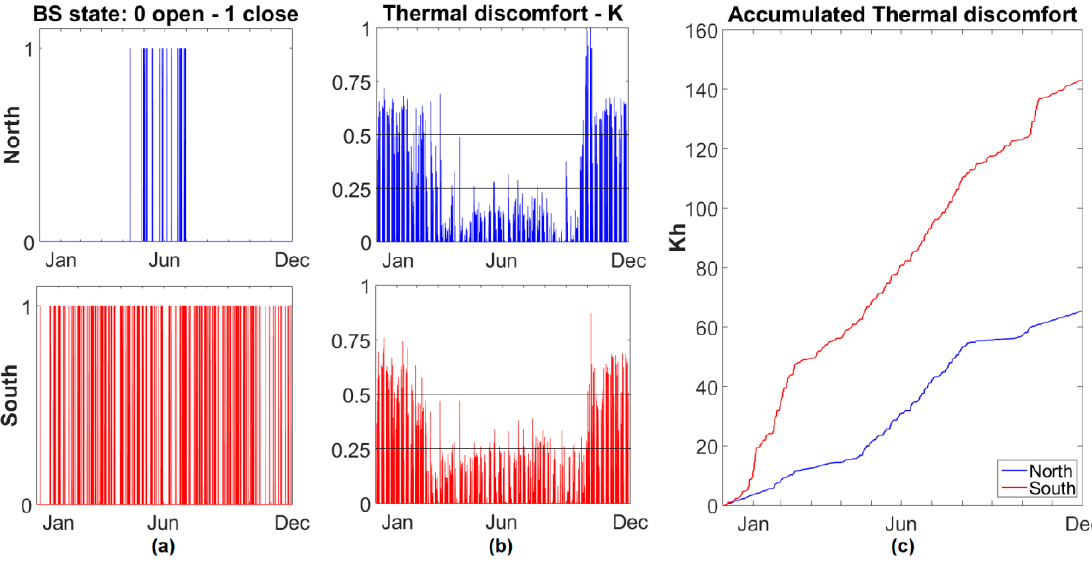
Figure 8. Enhanced BSC study. BS state ( a ), thermal discomfort ( b ) and accumulated thermal discomfort ( c ) for north and south offices.